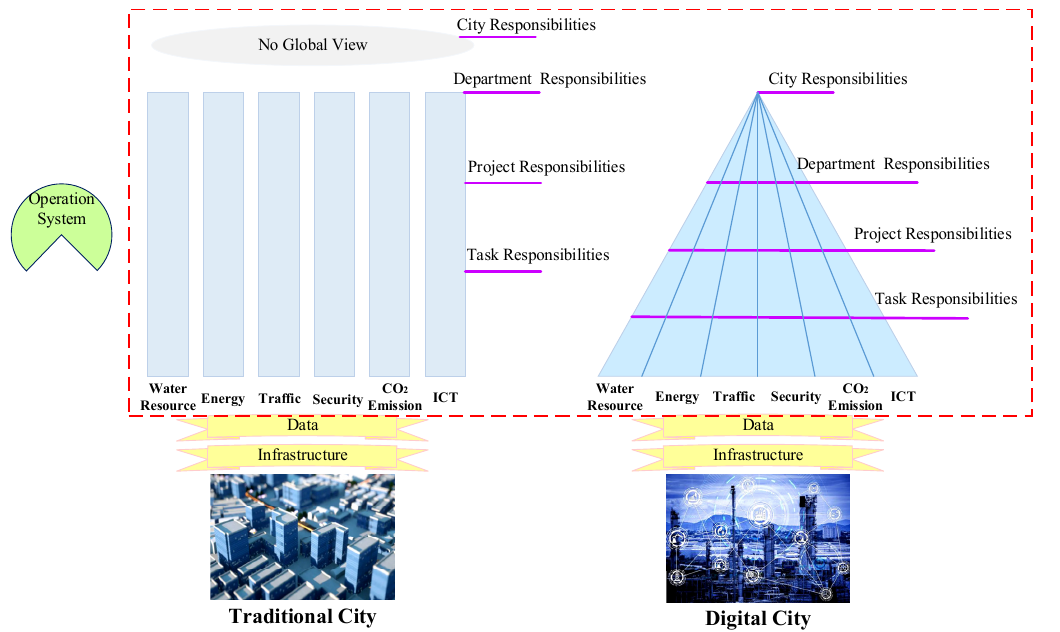
Figure 1. Comparison of operation modes between traditional cities and DCs.